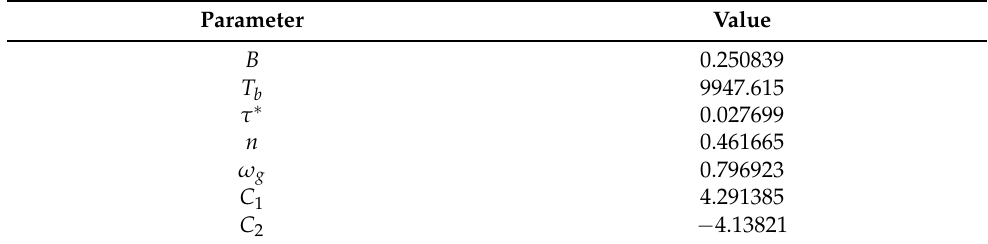
Table 1. Rubber characterization: Parameters of the “Reactive Viscosity Model”.